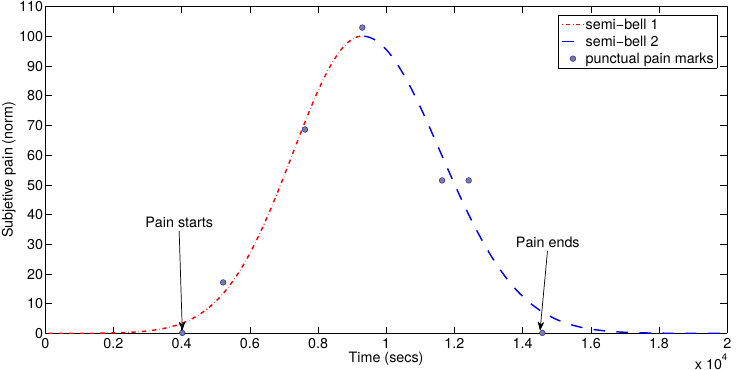
Figure 2. Modeling of subjective pain evolution